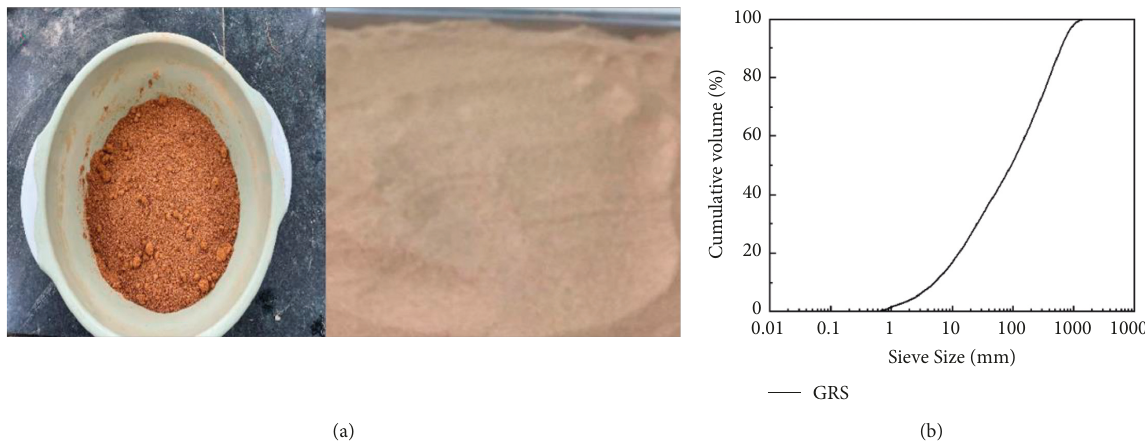
Figure 1: Material diagram. (a) Granite residual soil. (b) GRS particle